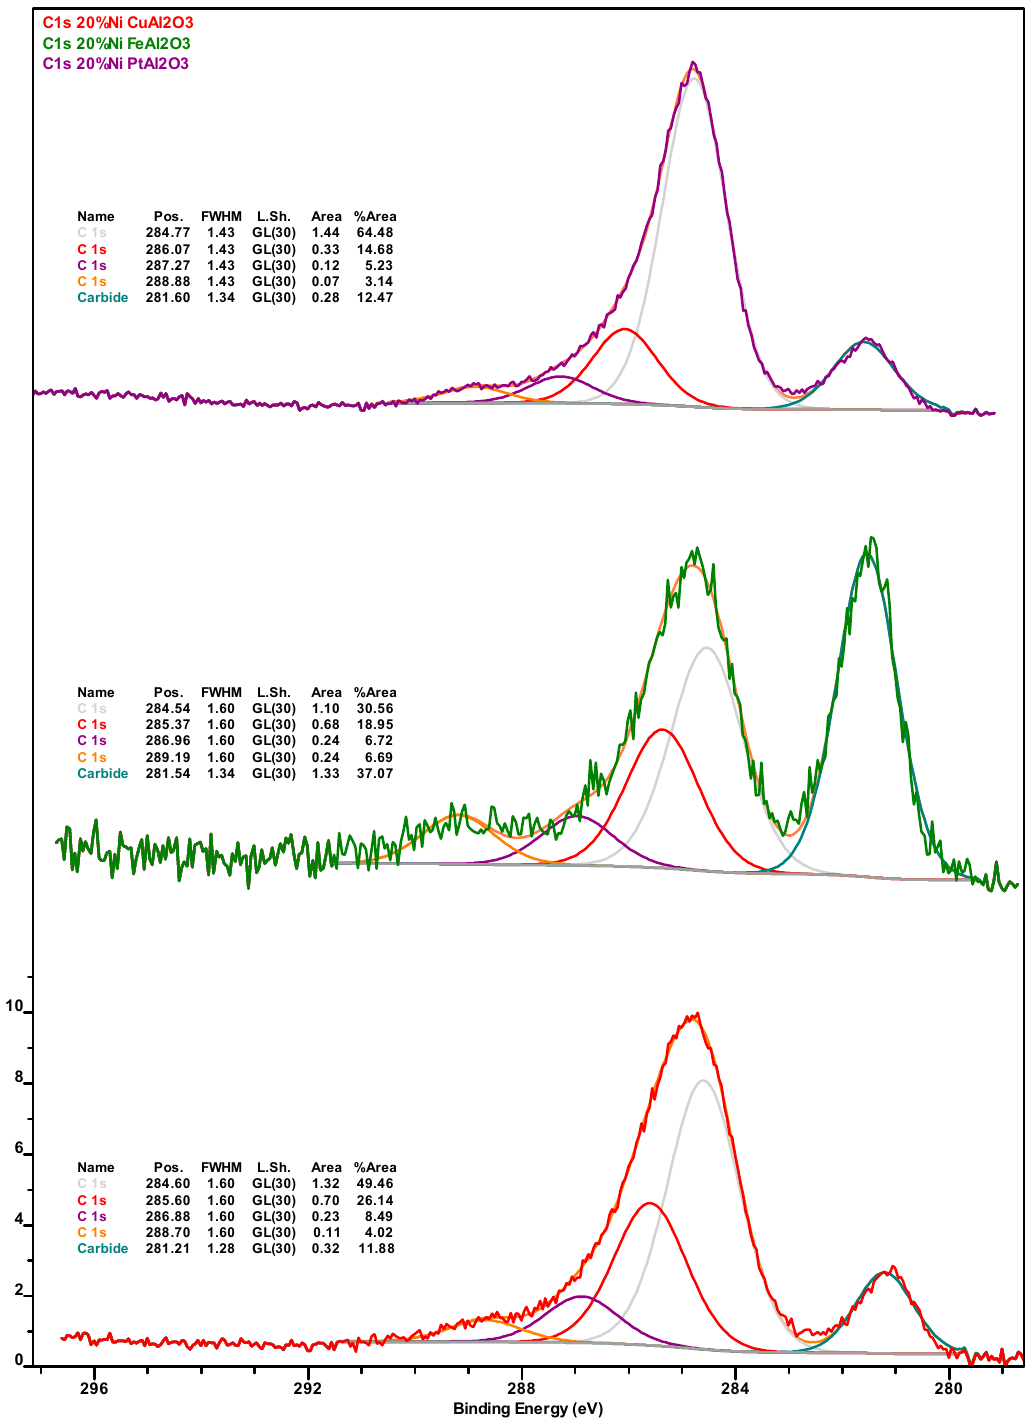
Figure A4. Carbon 1s X-ray photoelectron spectra of the spent Ni-Cu (red spectrum), Ni-Fe (green spectrum), and Ni-Pt (purple spectrum) catalysts recovered from the deoxygenation experiments.